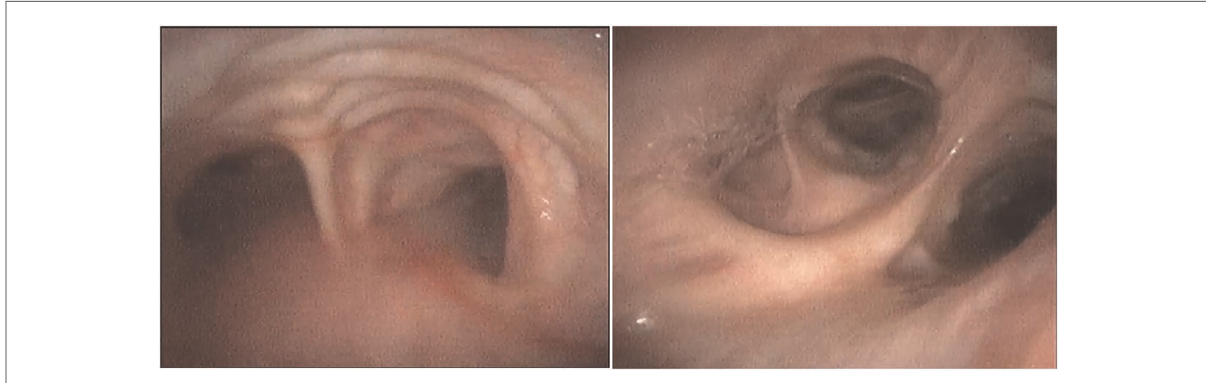
FIGURE 3 Bronchoscopy images showing that the mucosa protrudes between cartilaginous rings in trachea (left) and diverticula in the opening of the middle and lower lobes of the right lung